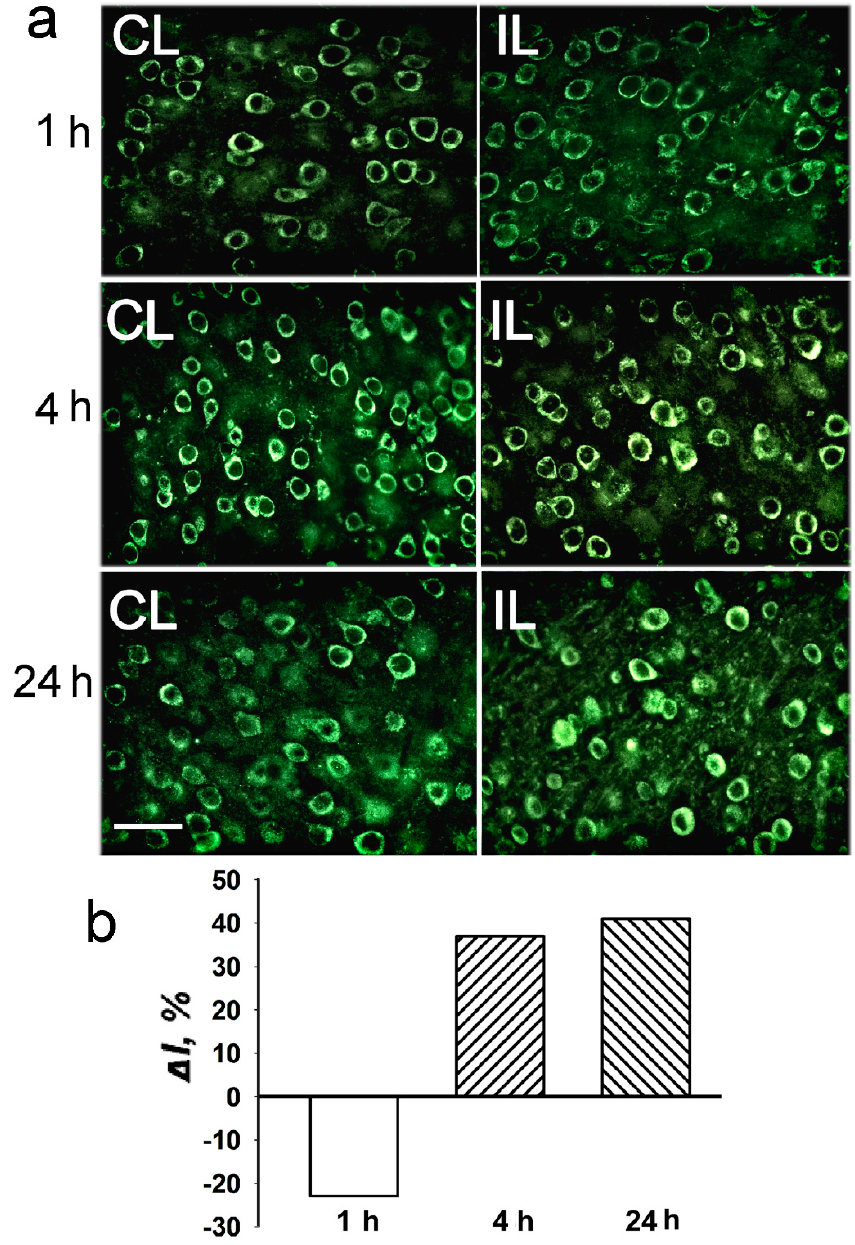
Figure 6. The cellular distribution of histone deacetylase HDAC4 in the penumbra at 1, 4 or 24 h after photothrombotic stroke in the rat cerebral cortex. ( a ) The typical immunofluorescence images of the HDAC4 localization in the ischemic penumbra (IL, right column) and control contralateral cortex (CL, left column). Scale bar, 20 µ m. ( b ) Percent changes in fluorescence intensity of HDAC4-positive cells in the ischemic penumbra 1, 4 or 24 h after photothrombotic stroke in the rat cerebral cortex relatively to that in the control contralateral cortex. ∆ I % is the mean corrected total cell fluorescence (CTCF) averaged in the penumbra minus mean control CTCF / mean control CTCF × 100% (experiment versus control). n = 5.